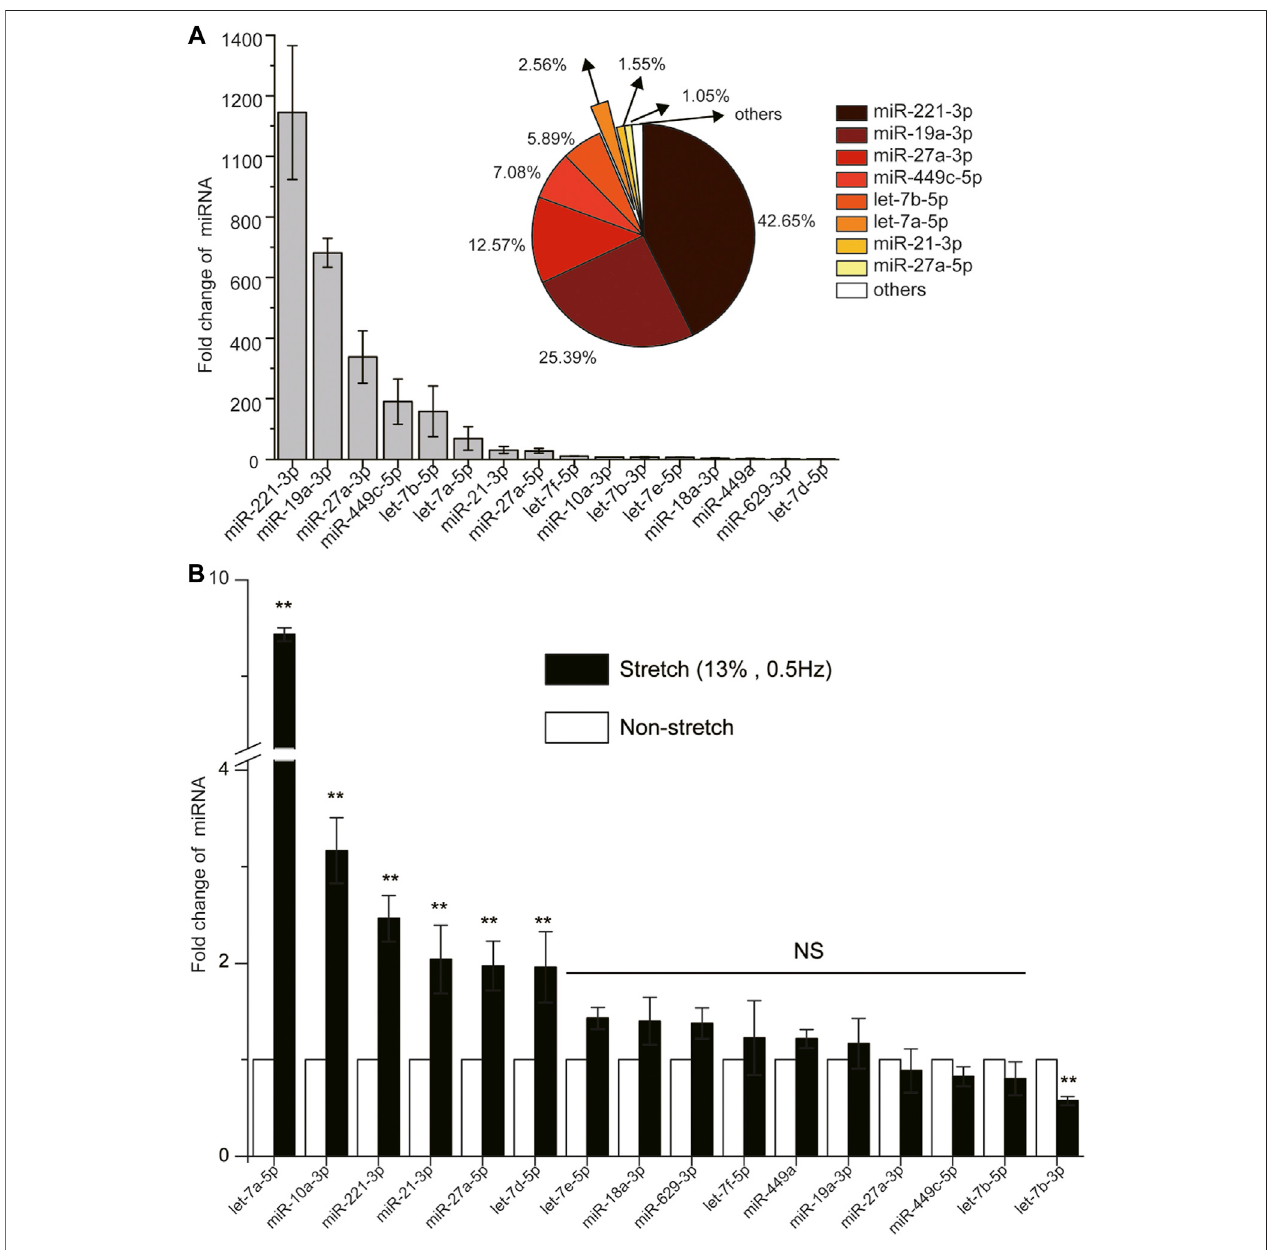
FIGURE1| Theexpression of16miRNAs (cyclethreshold,Ct valuebelow36)with/without high stretchinASMCs. (A) Thefoldchangeof16miRNAs withouthigh stretch. The pie chart in the top right insert shows the percentage distribution of the top eighthighly expressed miRNAs ofover 1% in ASMCs. (B) The fold change of16 miRNAs in ASMCs with high stretch (13% strain, 0.5 Hz). All data are presented as means ± S.E.M. (n = 3). * p < 0.05, ** p < 0.01, NS p > 0.05.